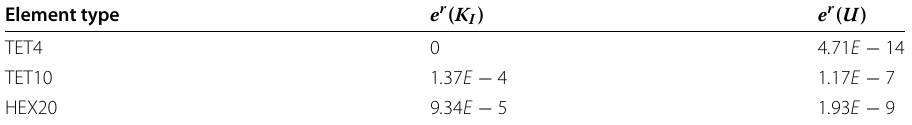
Table 3 Relative difference between strain energy ( U ) and stress intensity factor ( K I ) computed with HNA Abaqus-ISET and ISET only Element type